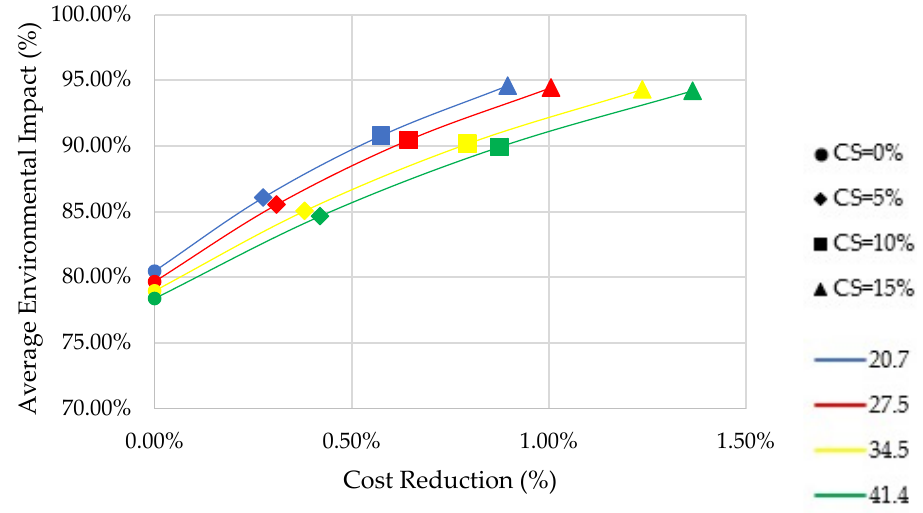
Figure 10. Seven-story building environmental impact vs. cost reduction plots by concrete strength.